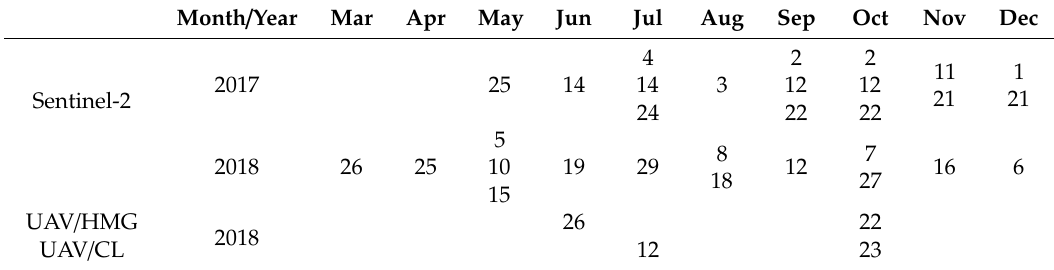
Table 1. Image’s acquisition dates (Sentinel-2 Level-2A images and UAV